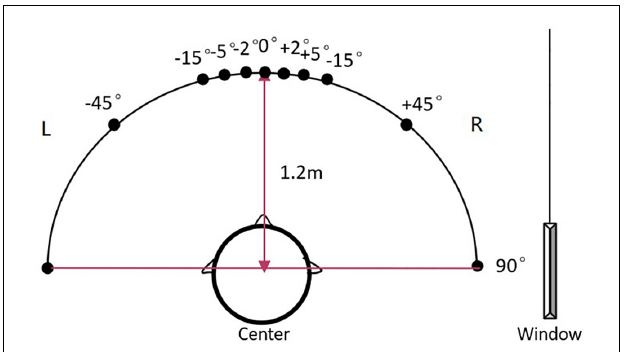
FIGURE 1 | The diagram of the sound localization test. The sound localization test used a 180 ◦ horizontal arc-shaped bracket (black line) with a 1.2 m radius to place loudspeakers. The middle point was marked as 0 ◦ and four symmetrical positions ( ± 45 ◦ , ± 15 ◦ , ± 5 ◦ , and ± 2 ◦ ) were selected as test angles. Two calibrated speakers (4 cm diameter) with the same frequency response were symmetrically fixed on the left and right sides of the bracket. Participants were asked to seat at the center of the arc facing 0 ◦ . During the test, the stimulus was played by two speakers at one of the symmetrical positions in order. For example, a stimulus was played from the speakers at –45 ◦ for the first 500 ms, then was played from the speakers at +45 ◦ for the last 500 ms and made a location